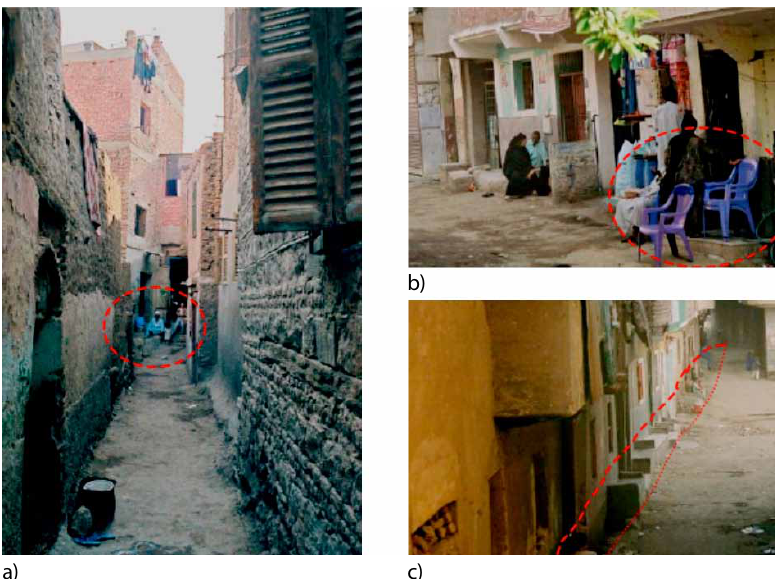
fig. 3 a, b, c: Sitting and talking is one of the prevailing social activities for residents in Manial Sheha, that both men and women undertake in open spaces and fina’s. a few examples; in photograph (a) residents in one of the culs-de-sac sitting in the front of their house. In photographs (b) and (c) residents are sitting on mastabas in the front of their houses, or as in (b) on plastic chairs in the front